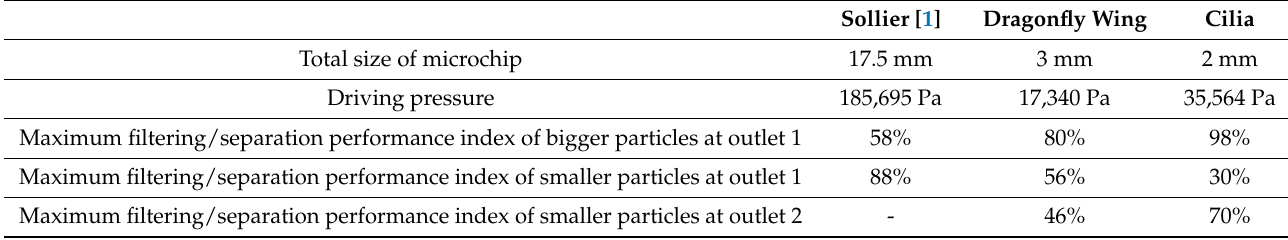
Table 4. Microchip performance subjected to Sollier’s